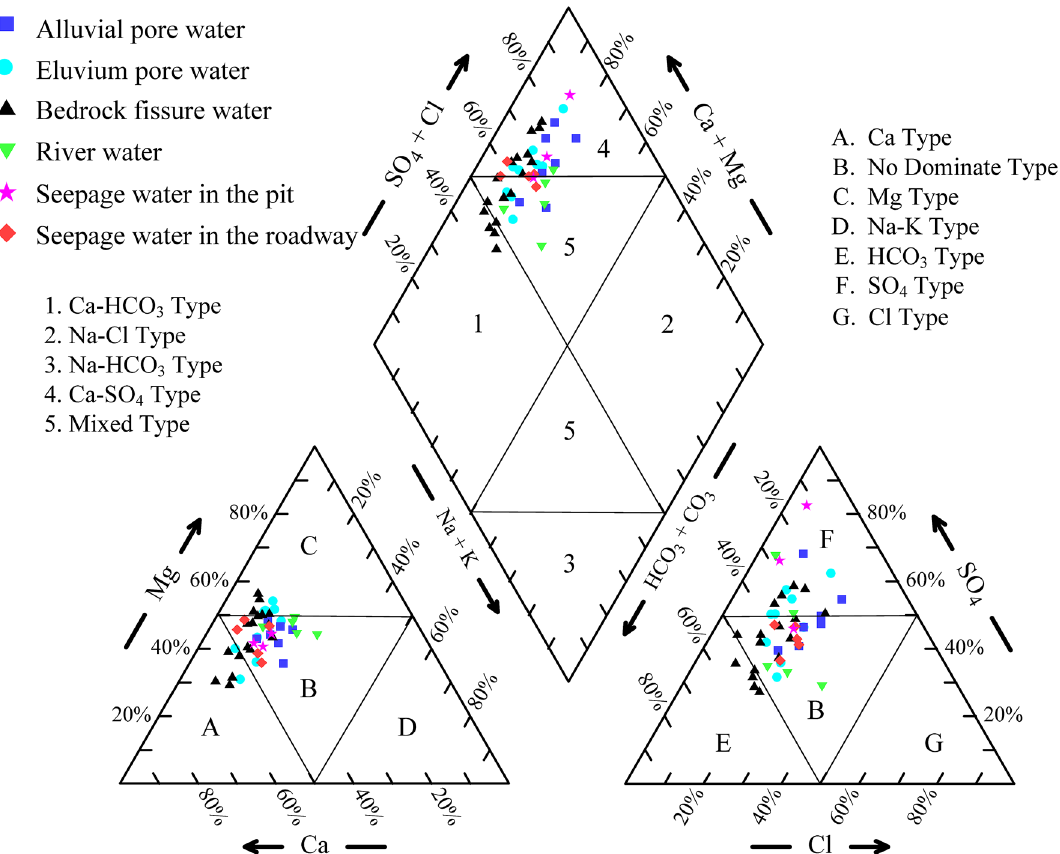
Figure 4. Piper diagrams of water samples in the study